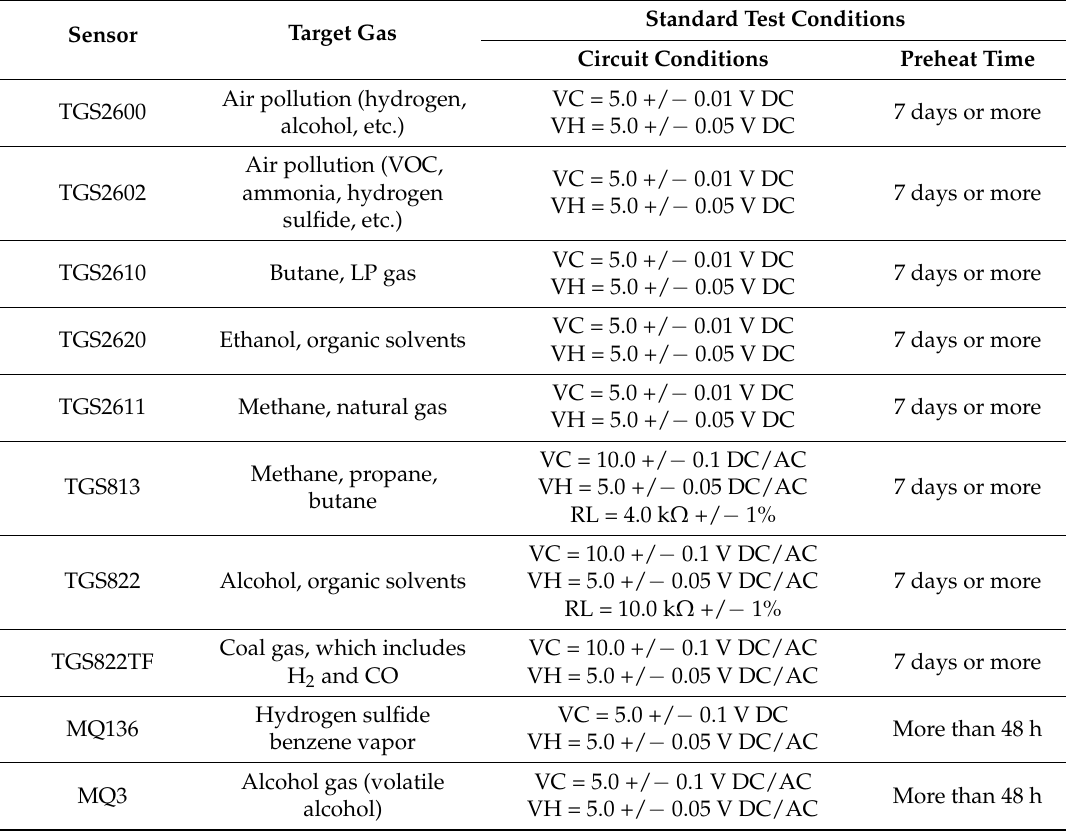
Table 2. Details of sensor